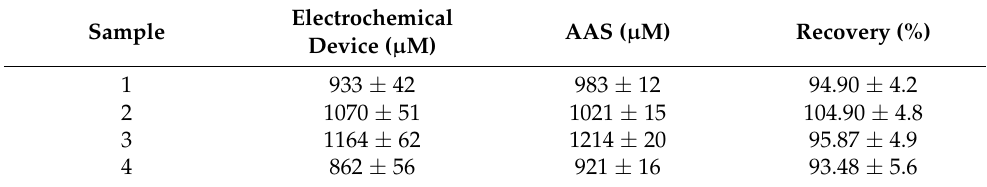
Table 3. Comparison of electrochemical device and AAS in determining Ca 2+ concentrations in dairy cow serum